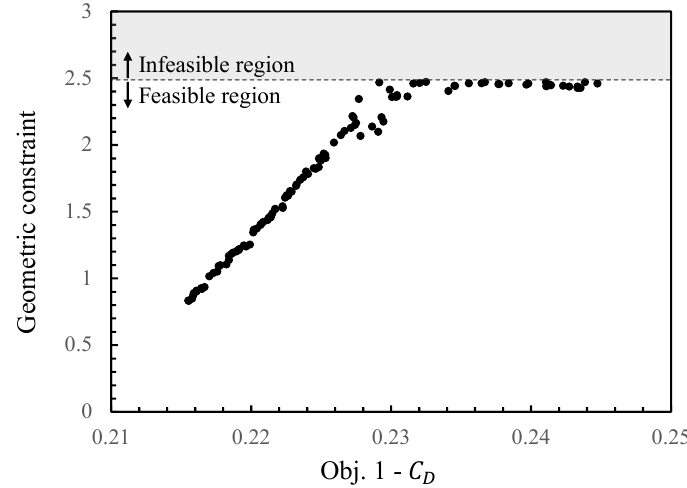
Figure 11. Drag coefficient and geometric constraint for optimal designs.